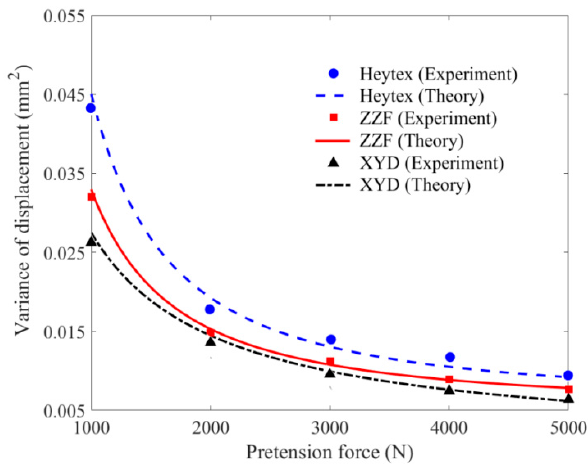
Figure 21. Variance value of displacement versus membrane material.